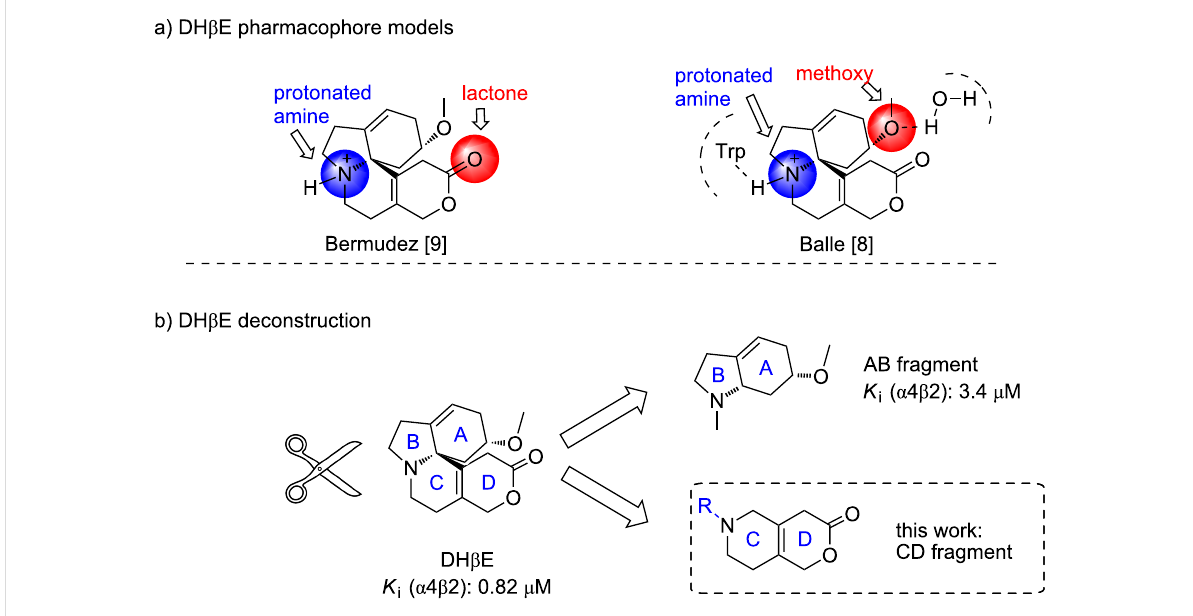
Figure 1: DH β E and related structures. The K i values of the compounds at the rat α 4 β 2 nAChR subtype determined in a [ 3 H]cytisine binding assay are given [3].